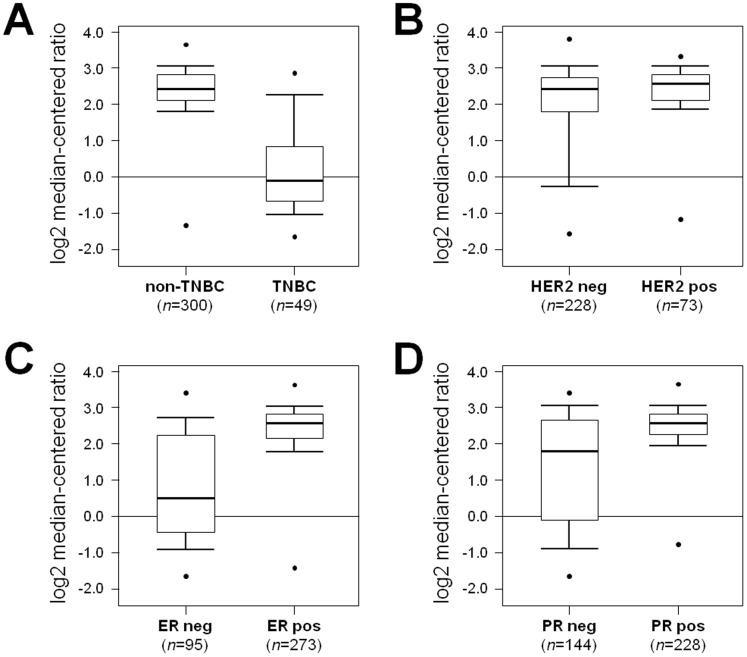
Androgen receptor mRNA expression is down-regulated in TNBC cases.Expression microarray results of the TCGA consortium data set was analyzed, and statistical significance was calculated using the Oncomine website (www.oncomine.org). Box plots show differences in mRNA expression between the different classes according to TNBC (A), HER2 (B), ER (C), and PR (D) status. Data are presented as box plot distribution (Line within the boxes =  median value).